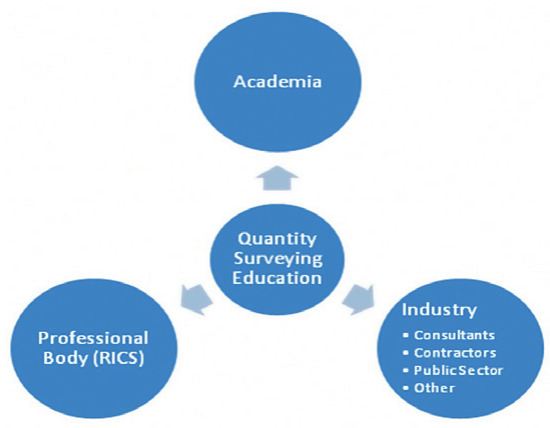
Figure 1. Key stakeholders influence on quantity surveying